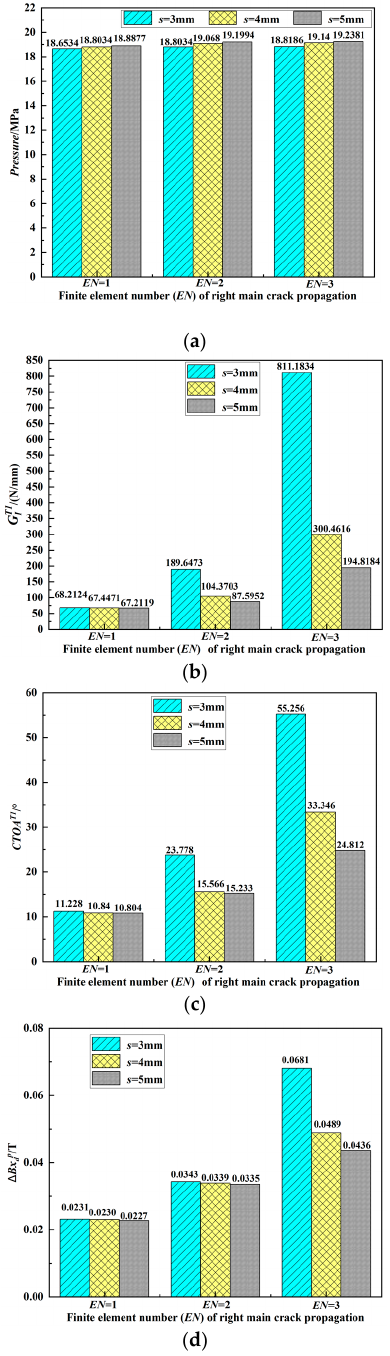
Figure 10. Influence of crack tip distance on main crack propagation. ( a ) EN = 1, 2, 3, P - s , ( b ) EN =1, 2, 3, G IT 1 - s , ( c ) EN =1, 2, 3, CTOA T 1 - s , ( d ) EN = 1, 2 , 3, ∆𝐵𝑥 (cid:3031)(cid:3043) - s